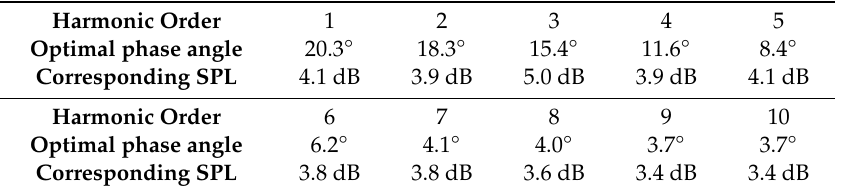
Table A1. Di ff erent orders of the BPF harmonics a ff ecting the accuracy of the model at the location of the No.2